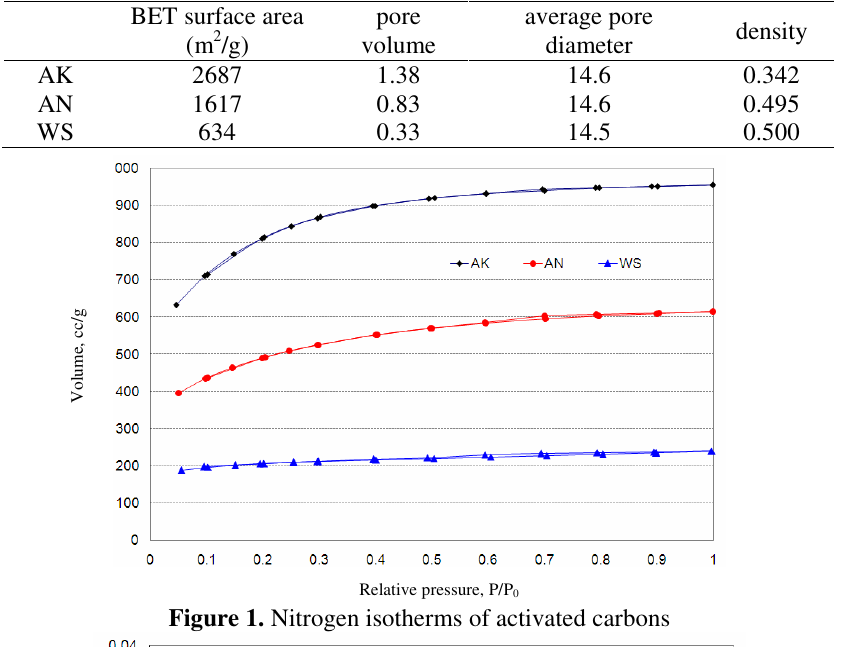
Table 1. The structural characteristics of activated carbon samples